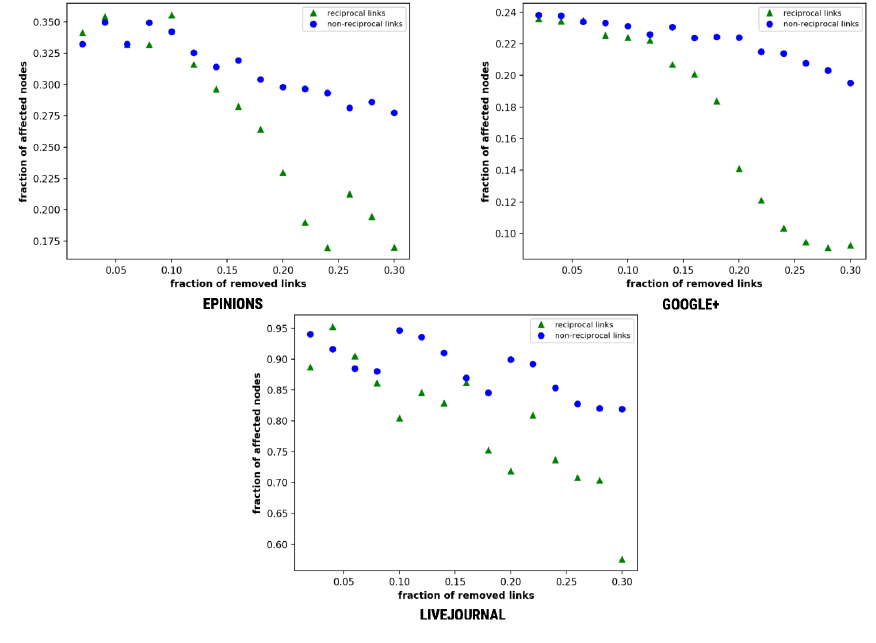
Figure 3. Simple diffusion—fraction of affected nodes as a function of the fraction of removed links.